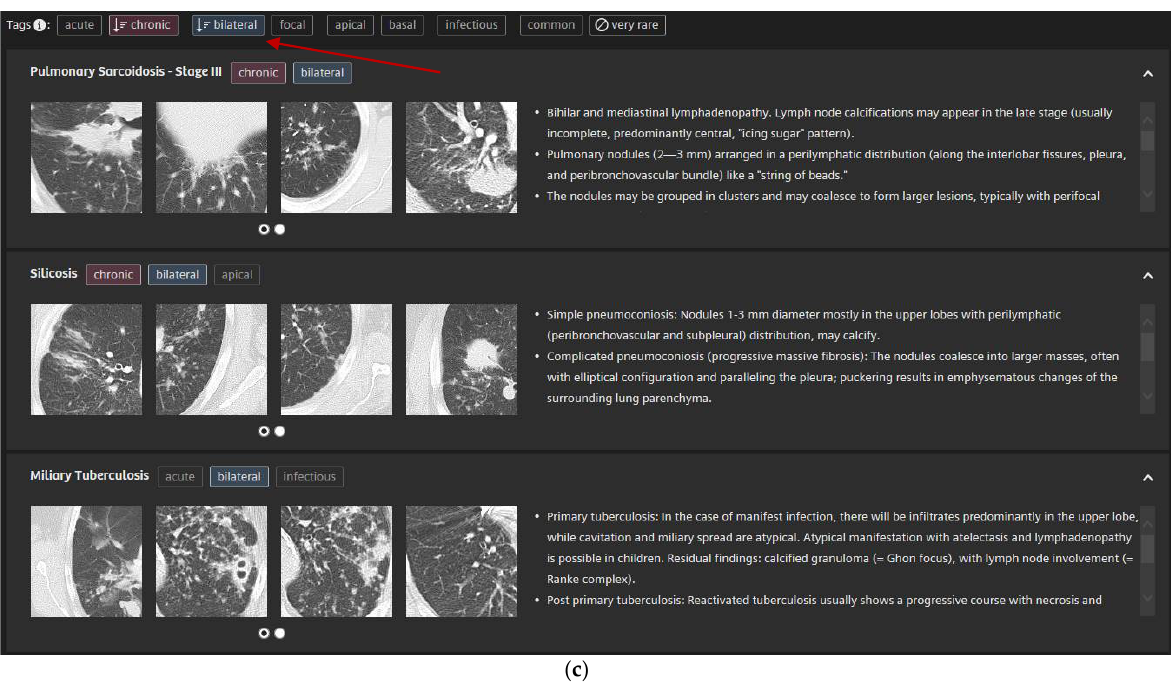
Figure 3. 5 mm transversal lung window CT of a 51-year-old female patient with pulmonary sarcoidosis and corresponding CBIR user interface: Participants were shown the corresponding 5 mm transversal lung window CTs for each case. They then drew a ROI into the area with their supposed dominant pattern ( a ). Readers were then presented the CBIR results ( b ) and could select high-level semantic features (e.g., chronic, bilateral) to filter retrieval results ( c ).